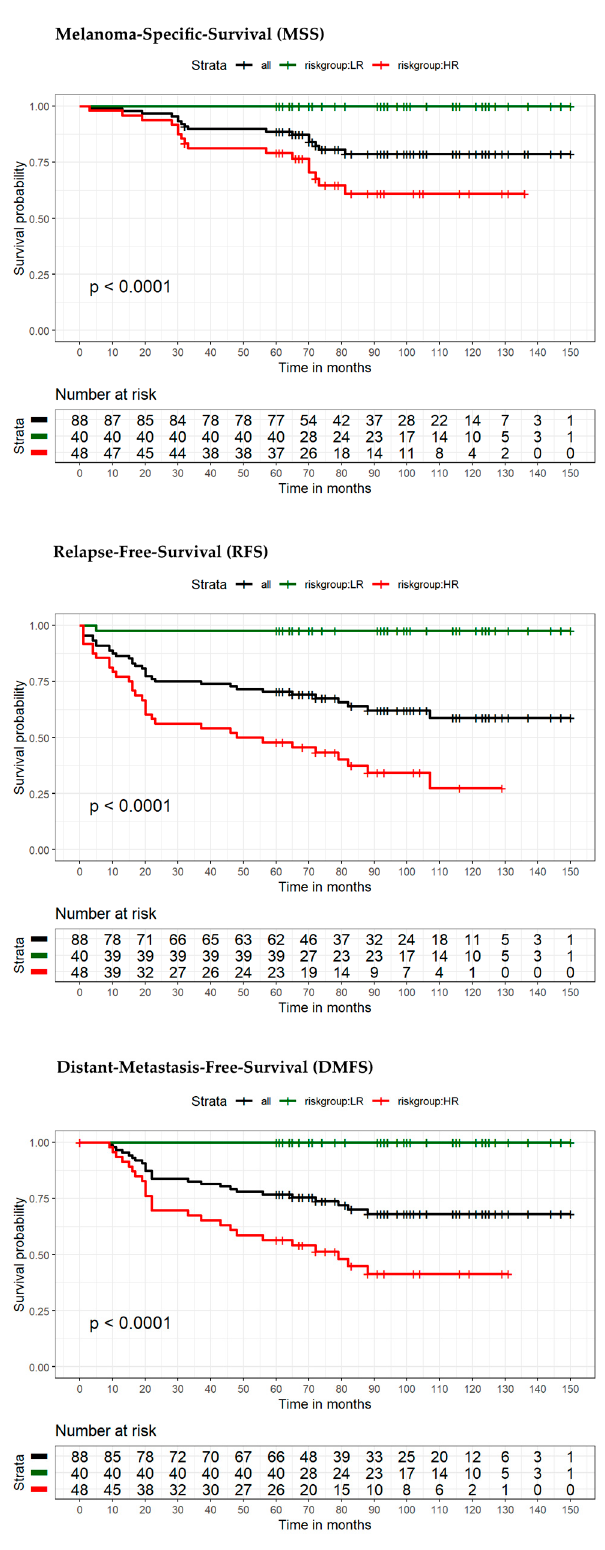
Figure 4. Kaplan–Meier analysis of the entire cohort ( n = 88 patients; AJCCv8 stages IB—IIIC) stratified with the seven-marker signature into-high risk or low-risk. Estimates of event-free survival for the endpoints MSS, RFS and DMFS at 5- and 10-year follow-up are displayed for: high-risk (in red), low-risk (in green), and all patients (black). Corresponding tables with the number of patients at risk are given below.